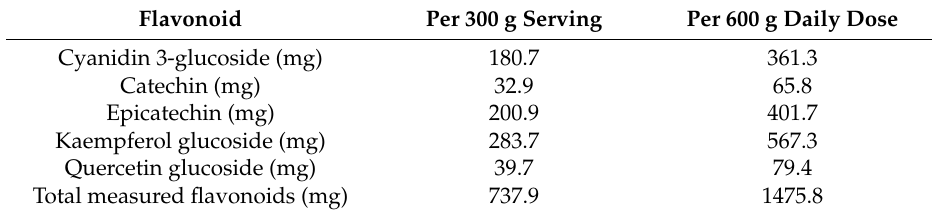
Table 1. Flavonoid content of blackberries provided to participants for 7 days as part of a controlled